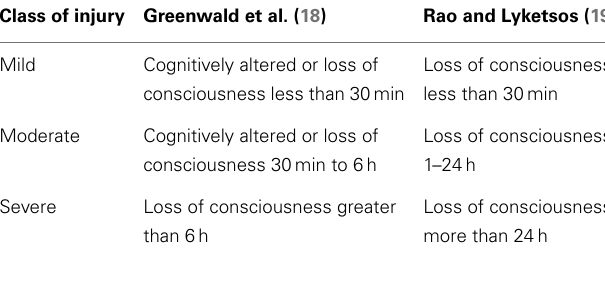
Table 2 | Comparison ofTBI classification